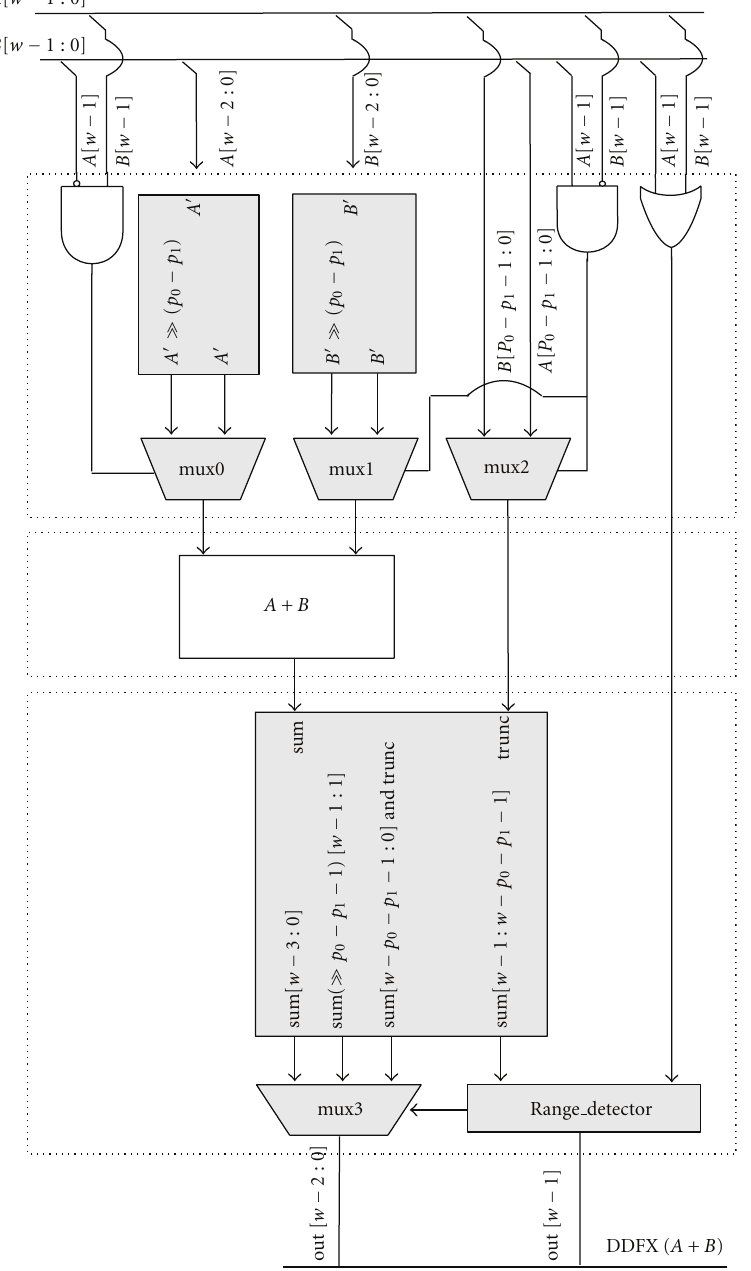
Figure 4: Dual fixed-point adder’s block diagram. The three stages of the adder are depicted by the dashed lines. Expressions like a 0 (cid:9) n 0 represent an arithmetical shift (with sign extension) to the right of n 0 bits for the operand a o . The components that need to be reconfigured to enable a change in precision in a dynamic dual fixed-point adder are shown in